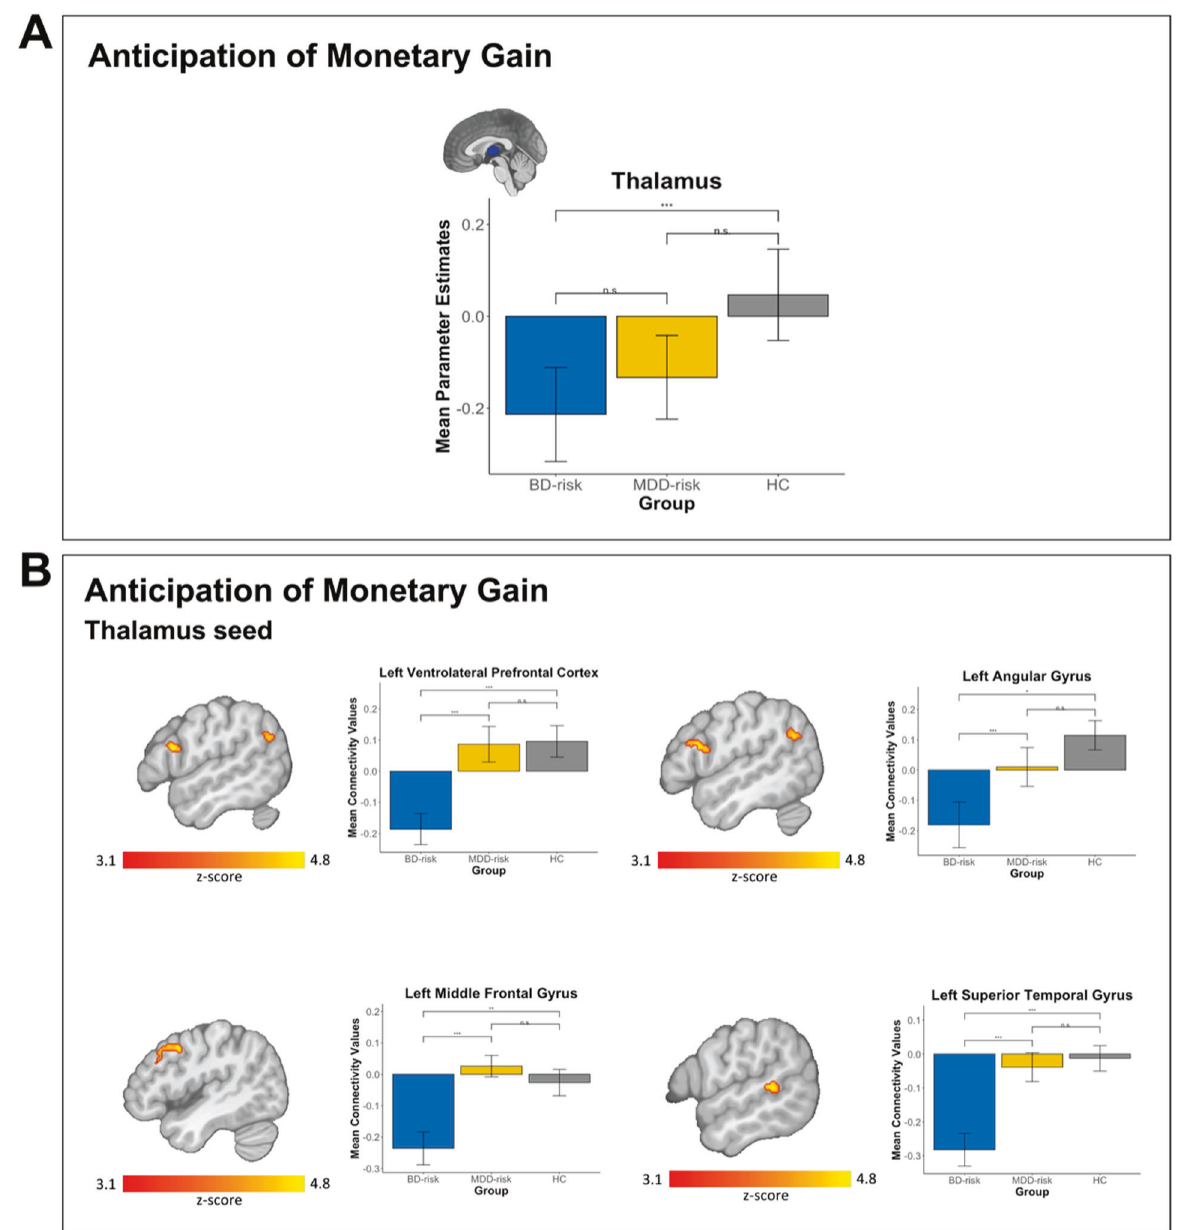
Fig. 1 Signi fi cant group differences within regions of interest and functional connectivity during reward processing. A BD-risk had decreased activation in the thalamus compared with MDD-risk and HC during anticipation of a monetary gain versus anticipation of no monetary gain. B The BD-risk group had reduced connectivity between the thalamus and left VLPFC and left angular gyrus compared with the HC group, and reduced connectivity between the thalamus and left middle frontal gyrus and left superior temporal gyrus compared with the MDD-risk group during anticipation of monetary gain versus no monetary gain. Z-statistics images were thresholded (Z > 3.1) using corrected- cluster signi fi cance threshold of p < .05. Legend: blue: BD-risk, yellow: MDD-risk, gray: HC. Left side of the image corresponds to the left hemisphere. Error bars are standard errors of the mean. n.s. = not signi fi cant; * p < 0.05, ** p < 0.01, *** p < and outcome of monetary gain relative to MDD-risk and HC. DISCUSSION Within BD-risk, decreased thalamus – angular gyrus connectivity This study identi fi ed neural markers of reward processing that was associated with increased impulsivity at baseline, decreased distinguish healthy youth at familial risk for BD from healthy youth thalamus – superior temporal gyrus connectivity was associated at familial risk for MDD and low-risk healthy-comparison youth at a with decreased prosocial behavior at follow-up, and decreased stage of relative psychological health. BD-risk had decreased cerebellar activation was associated with increased total dif fi cul- thalamus activation and hypoconnectivity between the thalamus ties at follow-up. and VLPFC, angular gyrus, middle frontal gyrus, and superior Reduced thalamic activation and connectivity during anticipa- temporal gyrus, while anticipating monetary gain relative to tion of gain may represent early and unique trait markers for BD- MDD-risk and HC youth. Voxelwise, BD-risk youth had less risk, or markers of risk for broader affective psychopathology [16]. activation in the cerebellum during anticipation of monetary gain